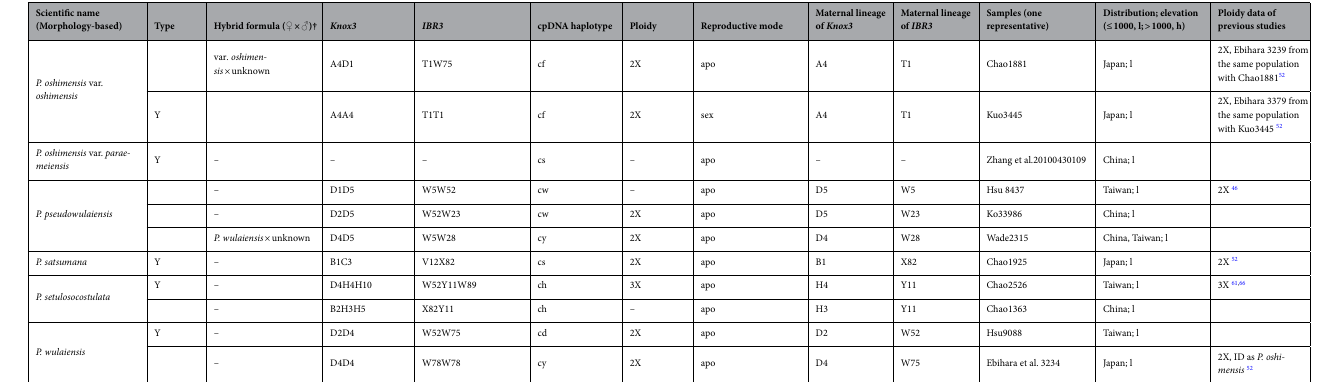
Table 1. The ploidy levels, cpDNA haplotypes, nDNA genotype, inferred maternal lineage, paternal lineage, and geographic distribution of samples in the Pteris fauriei group. Plants having identical morphology with the type specimens are indicated as Y. – No data. = The same as the above field. * Unasserted alleles. †Parents in the inferred hybrid formula are based on the species (or taxa) with homozygous genotypes.